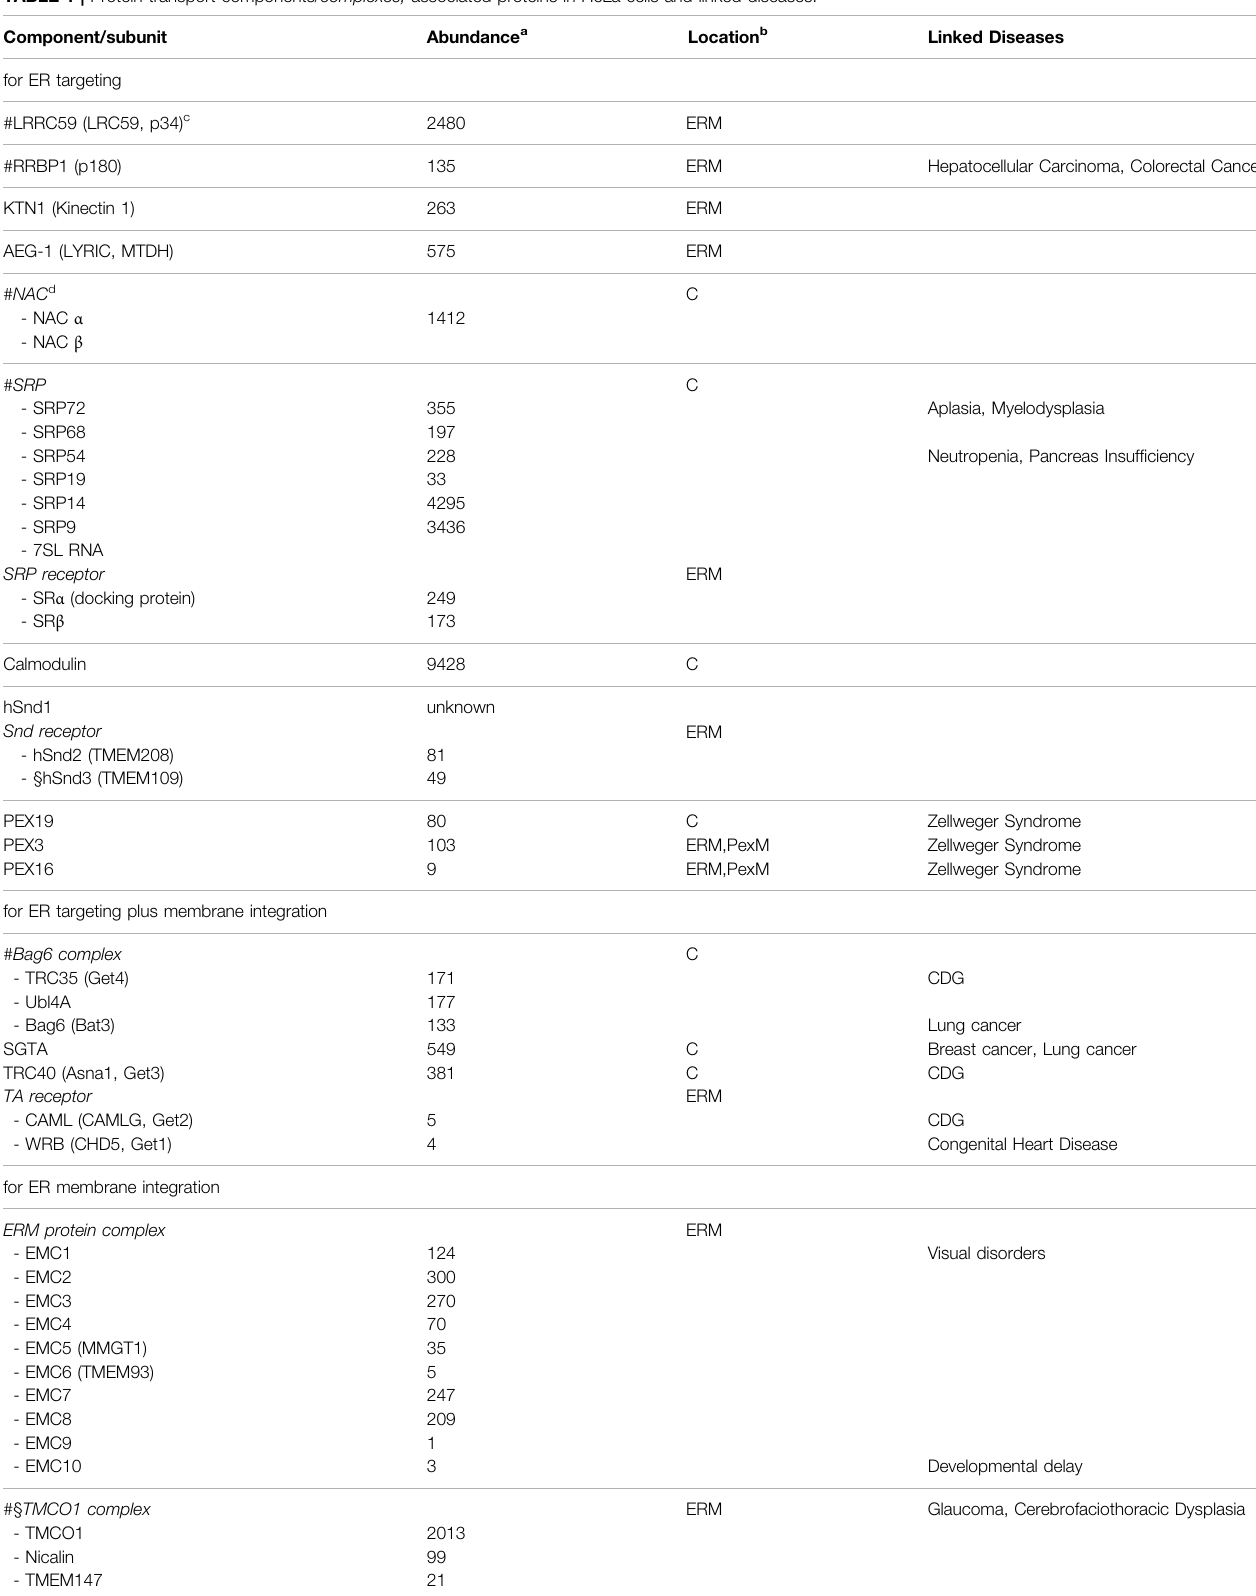
TABLE 1 | Protein transport components/ complexes, associated proteins in HeLa cells and linked